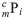
Geometric interpretation of POSIT.The pinhole camera with the center of projection at O
c, optical axis aligned with O
c, image plane uv at a distance f from O
c. The origin of object coordinate system at Pmci, m = 0,1,2,3, i is the number of object’s position, c is the camera coordinate system, mIi is the corresponding image point set, Pmci′ is the corresponding orthographic projecting point set.